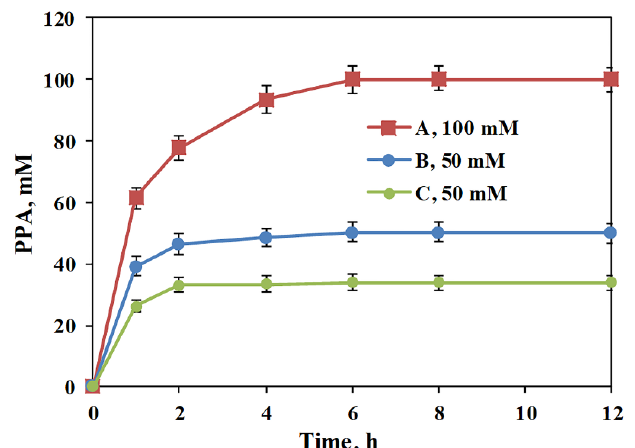
Figure 5. The time course of the formation of PPA with different biocatalysts. A: the biocatalyst was the MBP-PmLAAD cell lysate at 50 mg / mL, with 100 mM L-Phe; B: the biocatalyst was the MBP-PmLAAD cell lysate at 50 mg / mL, with 50 mM L-Phe; C: the biocatalyst was the PmLAAD whole cell at 100 mg / mL, with 50 mM L-Phe. The reactions were all conducted in a 50 mM, pH 8.5 Tris-HCl buffer at 37 ◦